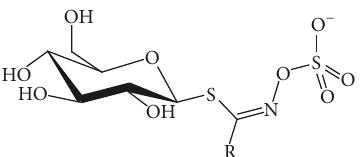
Figure 1: General structure of glucosinolates. Adapted from Grif- fiths et al. (1998)